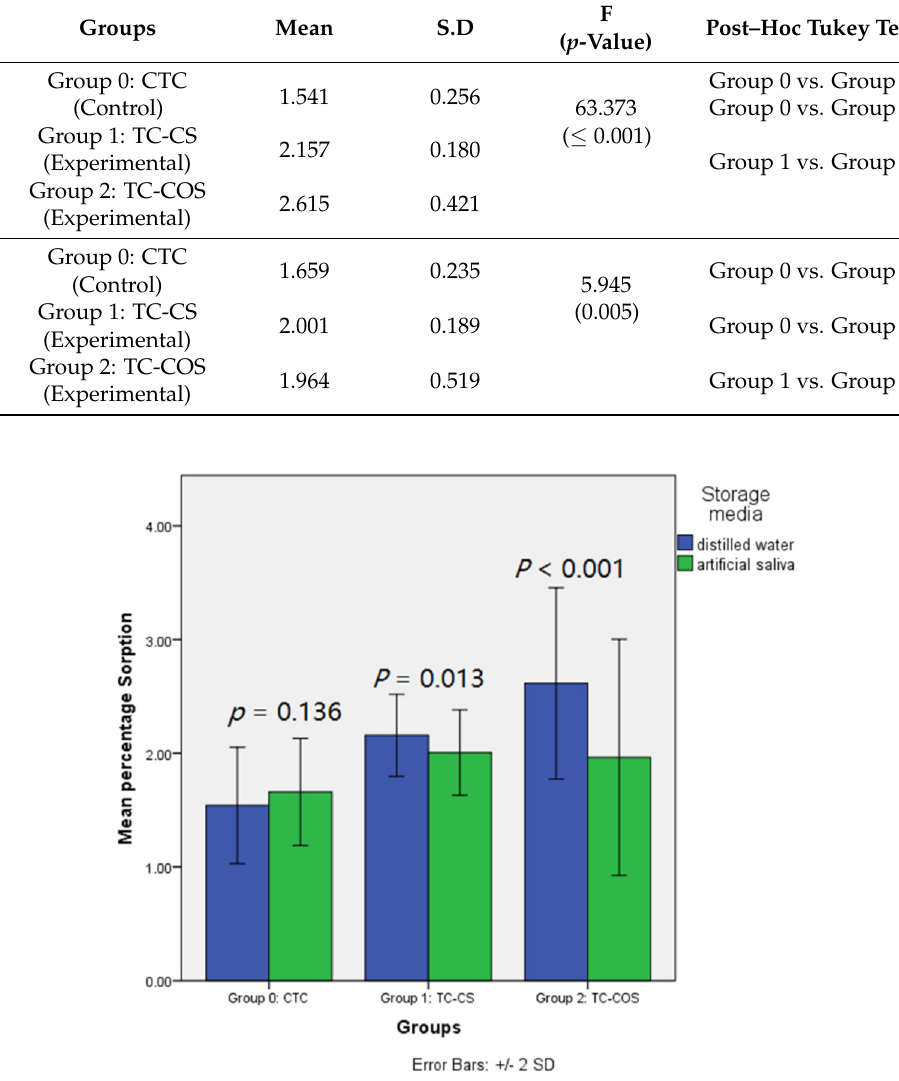
Figure 5. Effect of storage media on the sorption of tested